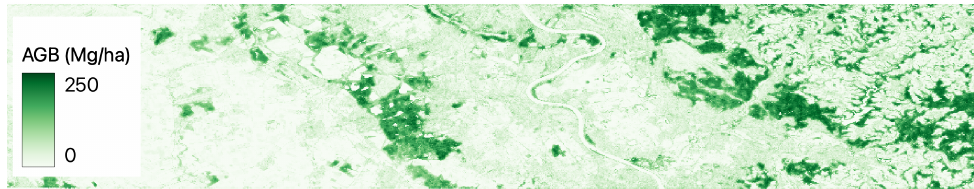
Figure 4. ReUse’s AGB predictions with raw bands and feature extraction in Central Europe.